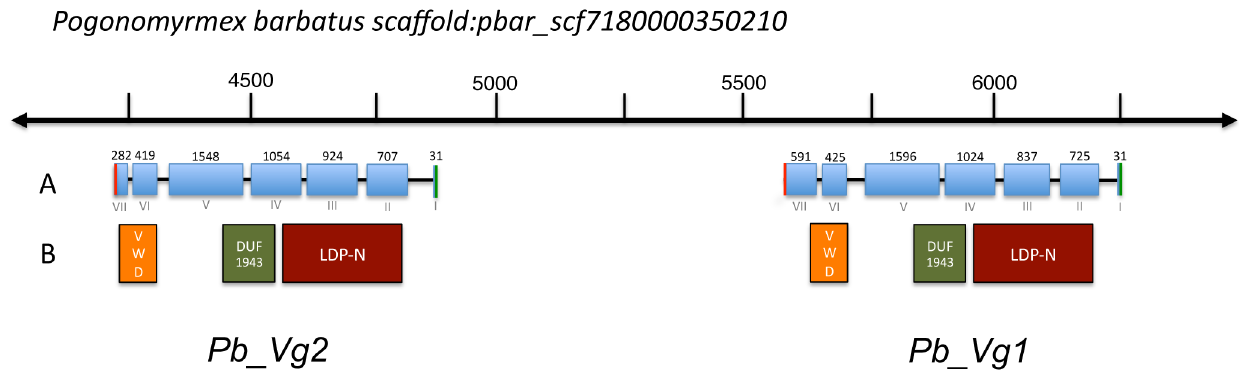
Figure 1. Genomic map of vitellogenin genes in Pogonomyrmexbarbatus . A. Exon-intron organization of Pb_Vg1 and Pb_Vg2 genes. Blue boxes represent exons and joining lines introns. Green and red lines indicate start and stop codons respectively. Exon number (I–VII) and size (31– 1596 bp) are indicated at the bottom and top of the figure. Exon VII in Pb_Vg2 (282 bp) is truncated with respect to Pb_Vg1 (591 bp). B. Localization of predicted protein structural domains: LPD-N (vitellogenin), DUF1943 and VDW.